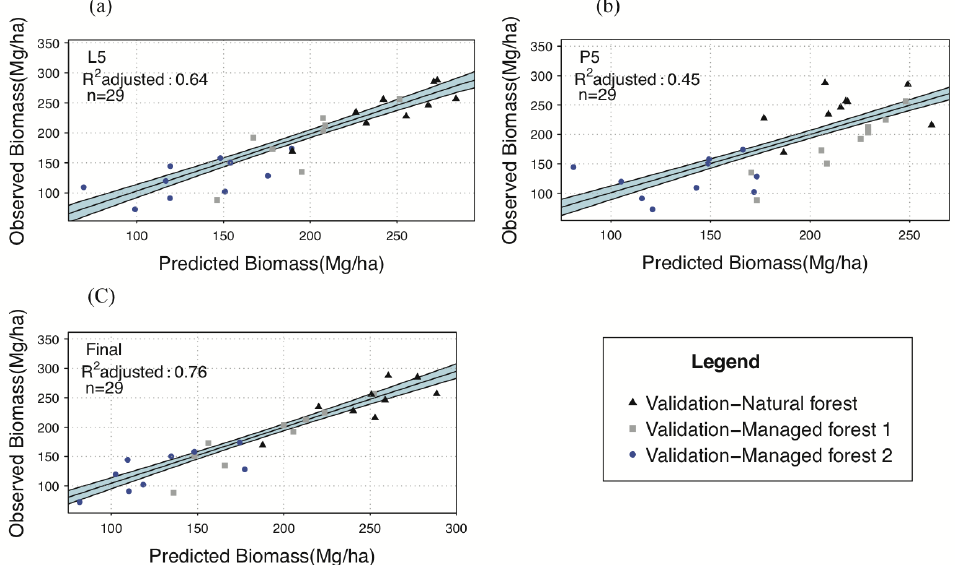
Figure 9. Predicted versus observed forest AGB (validation dataset); ( a ) Model L5: based on spectral reflectance and textures of ETM+ scene; ( b ) Model P5: based on backscattering and derived parameters of ALOS/PALSAR; and ( c ) Final model: based on ETM+ and ALOS/PALSAR data. Each point represents one field plot. The light blue polygon shows the area of 95% confidence interval and black solid line represents the fitted line.